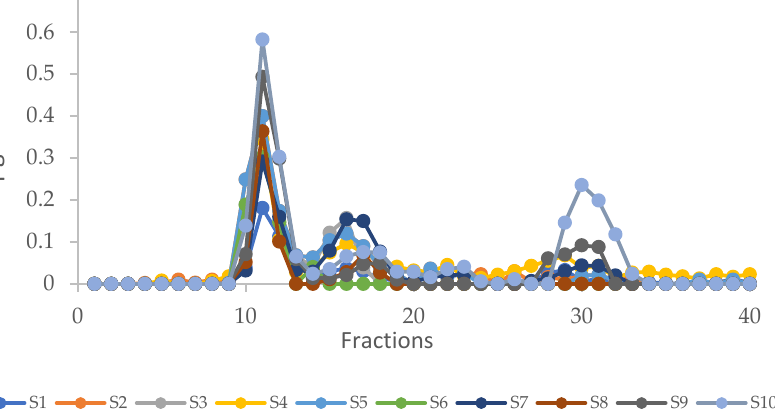
Figure 4. Iron chromatographic profiles after size exclusion chromatography of extracts from samples S1–S10. Iron concentration is expressed as µ g mL − 1 .